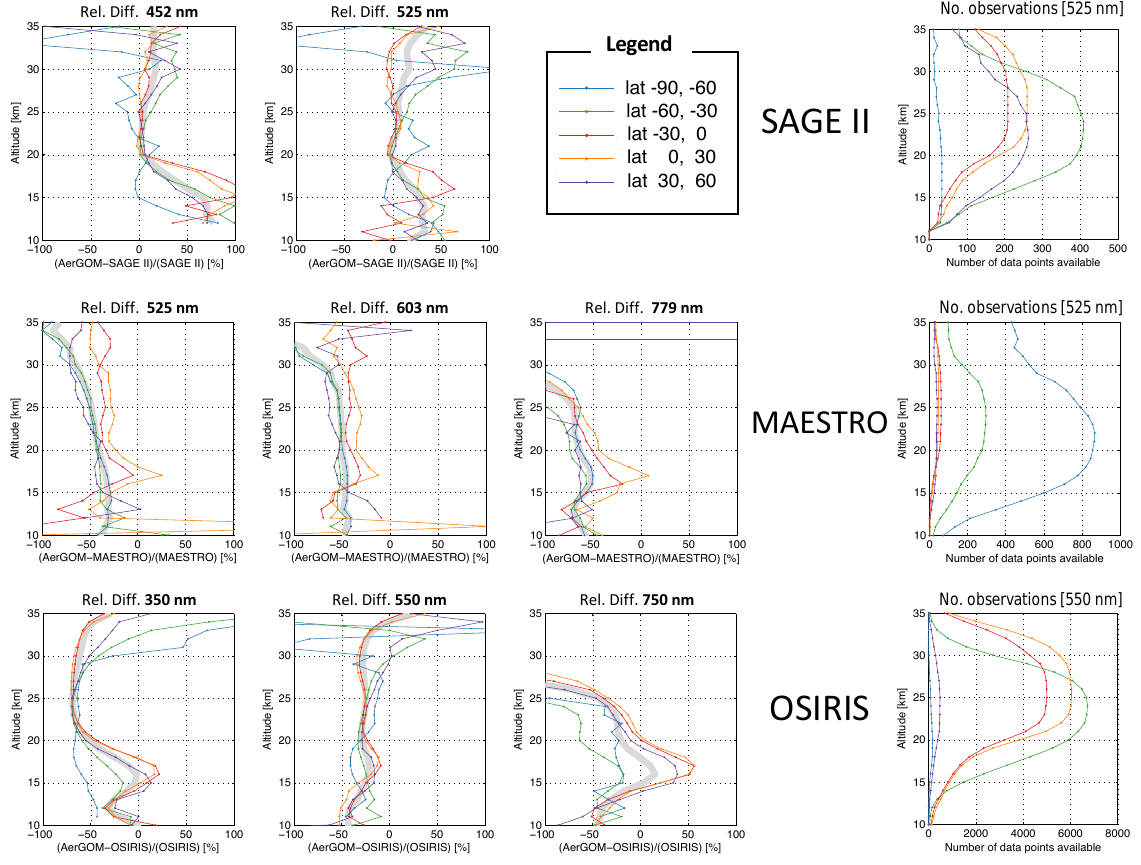
Figure 9. Relative differences between AerGOM and SAGE II, MAESTRO and OSIRIS datasets for different categories of latitudes of occultations, based on 30 ◦ latitude bands (left panels). The rightmost panel presents the number of observations for each comparison and latitude